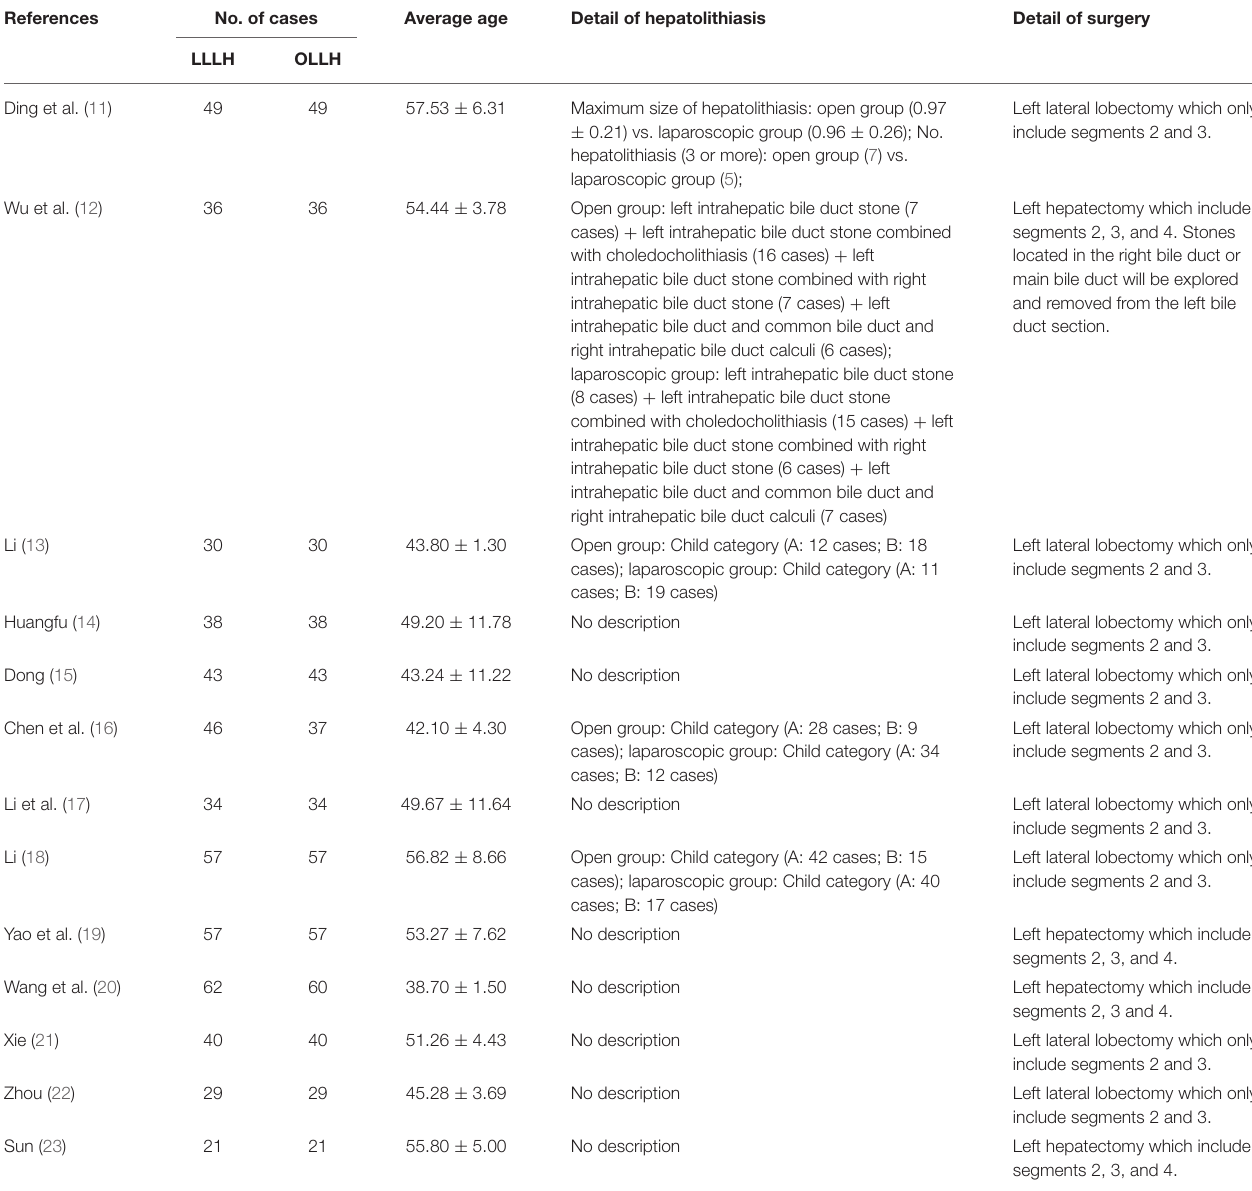
TABLE 1 | Baseline characteristics of included studies for